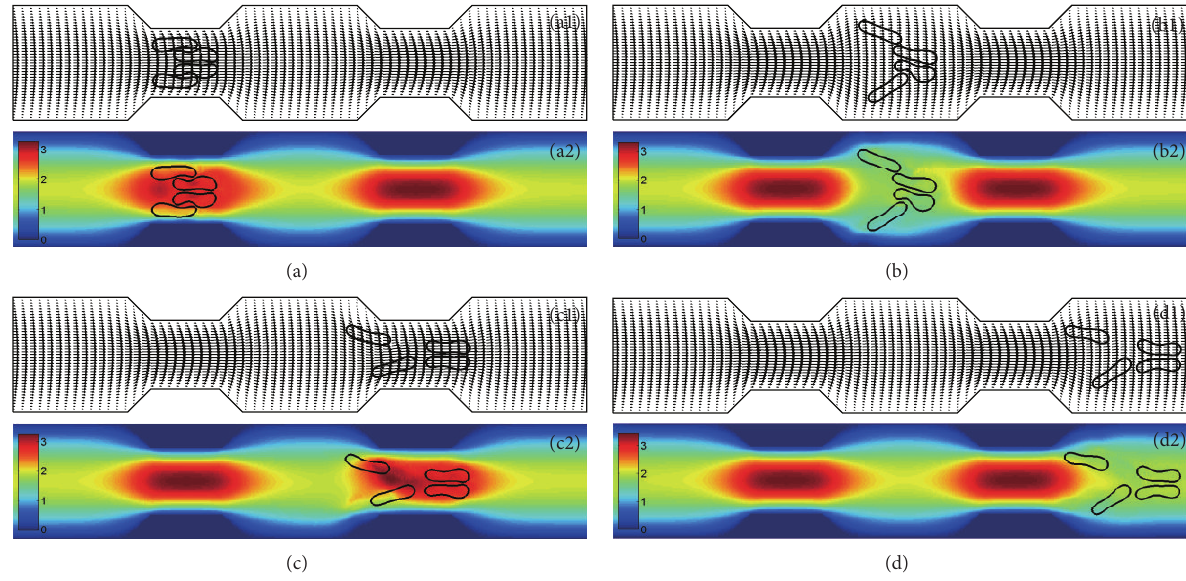
Figure 6: Motion and dissociation of a four-cell erythrocyte aggregate in a 12 𝜇 m stenotic channel at time instants (a) 𝑡 = 1.08 ms; (b) 𝑡 = 2.08 ms; (c) 𝑡 = 3.03 ms; and (d) 𝑡 = 3.93 ms. Velocity vectors (a1-d1) and axial velocity magnitude contours (cm/s) (a2-d2) are presented. The initial configuration for the aggregate is shown in Figure 1(c), and the aggregate is horizontally placed in the channel initially. The parameters used are 𝐷 𝑒 = 1.0 × 10 −2 𝜇 J/m 2 , 𝑘 𝑏 = 5.0 × 10 −13